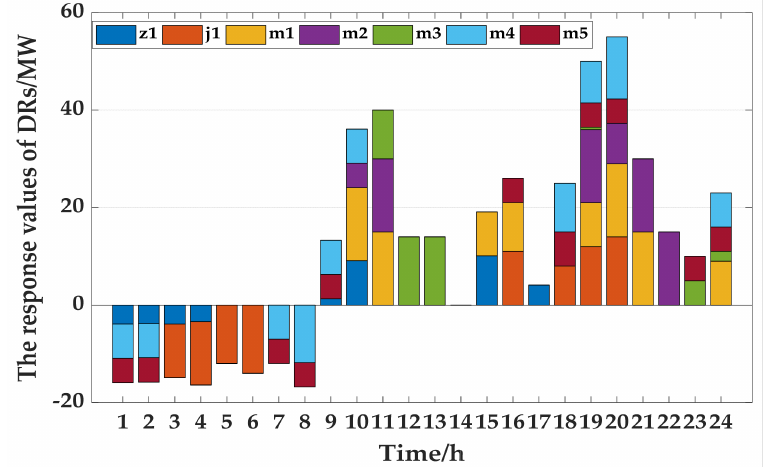
Figure 8. Response values of DRs at each period in Case 3.